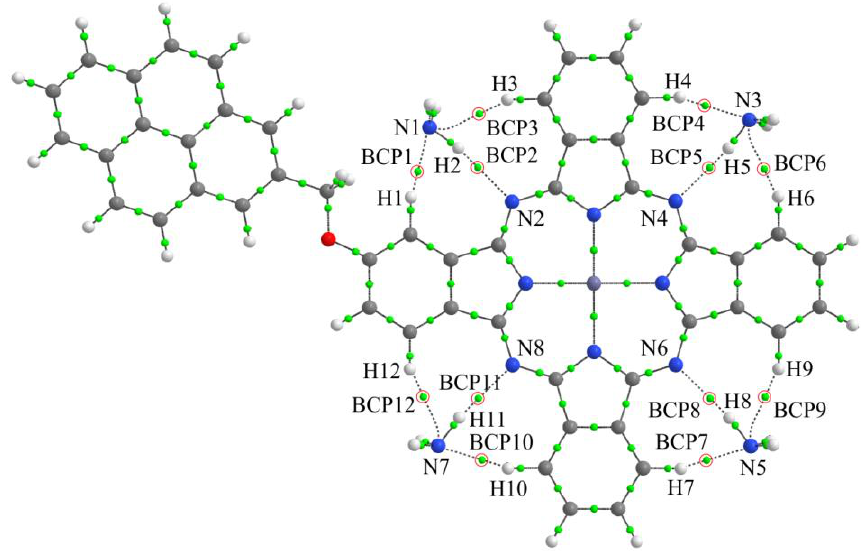
Figure 4. Bond critical points in the ZnPc-1py aggregate with four ammonia molecules (red circles show the BCP1-BCP12 points characterizing the interaction of NH 3 molecules with the phthalocyanine between the indicated atoms).